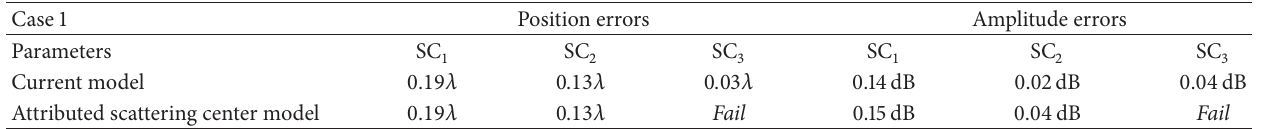
Table 2: Errors of amplitude and locations of the scattering centers.